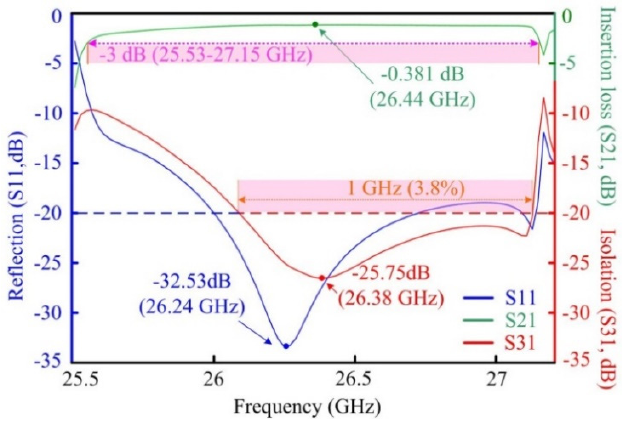
Figure 7. External characteristics of the modified PhC circulator.